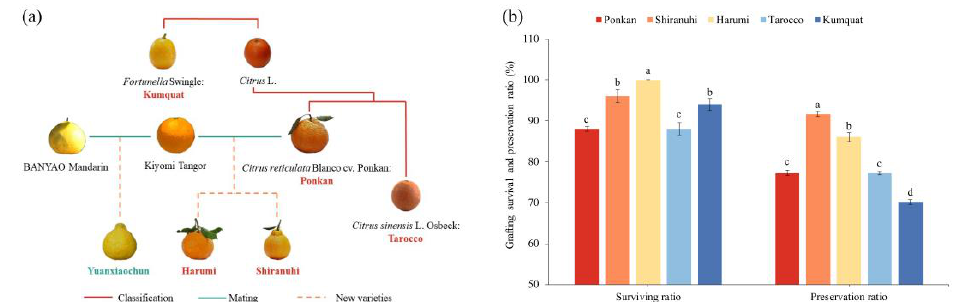
Figure 1. The genetic relationship, graft survival and preservation ratio. ( a ) Profile of the genetic